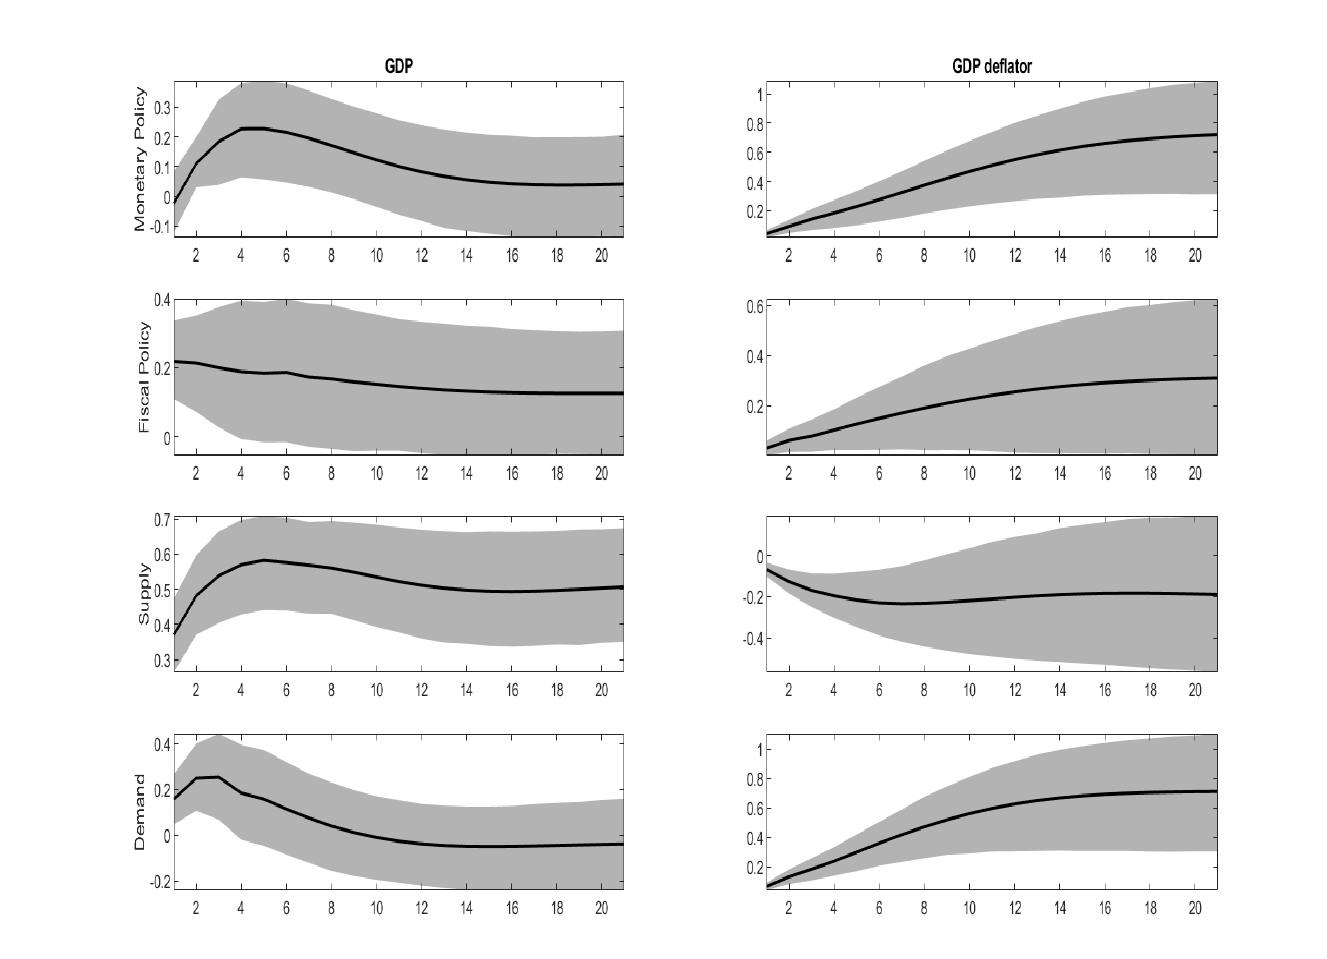
Figure 3. Impulse response functions. Solid line point estimate, gray areas 68% confidence